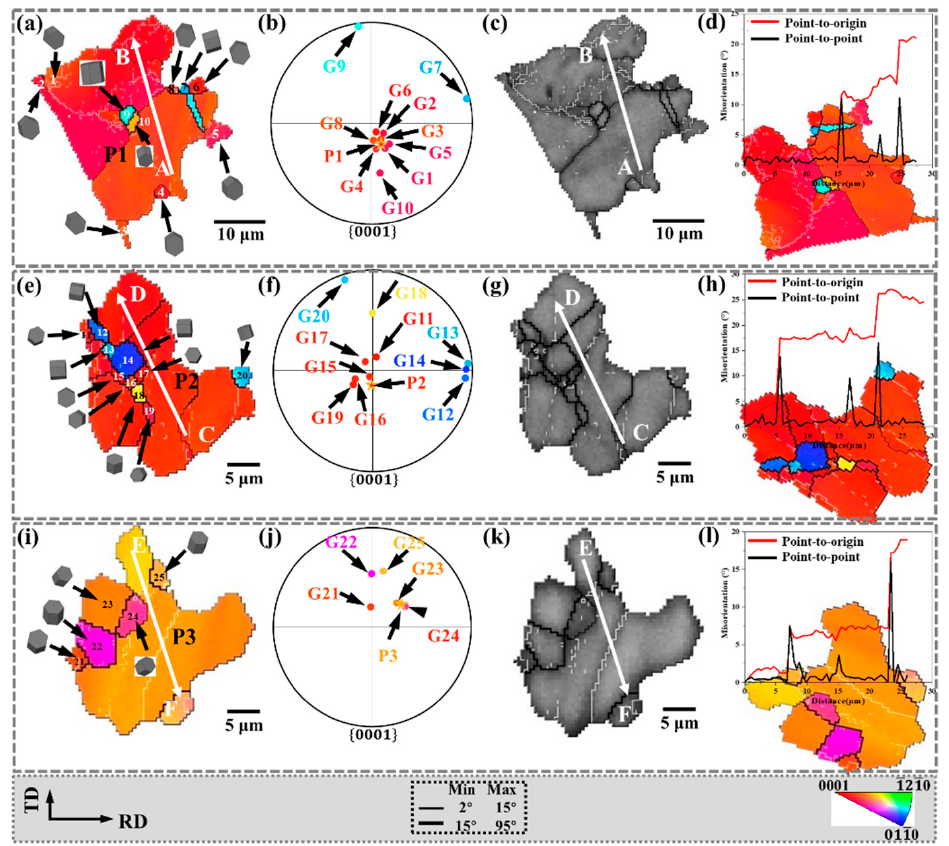
Figure 5. CDRX behavior of the black circle region in Figure 4 ( a , e , i ): the IPF, ( b , f , j ) {0001} pole figure, and ( c , g , k ) band contrast and ( d , h , l ) point-to-origin and point-to-point misorientations map along the black line AB, CD, and EF. The five-pointed star is the position of the parent grain on the {0001} pole figure.